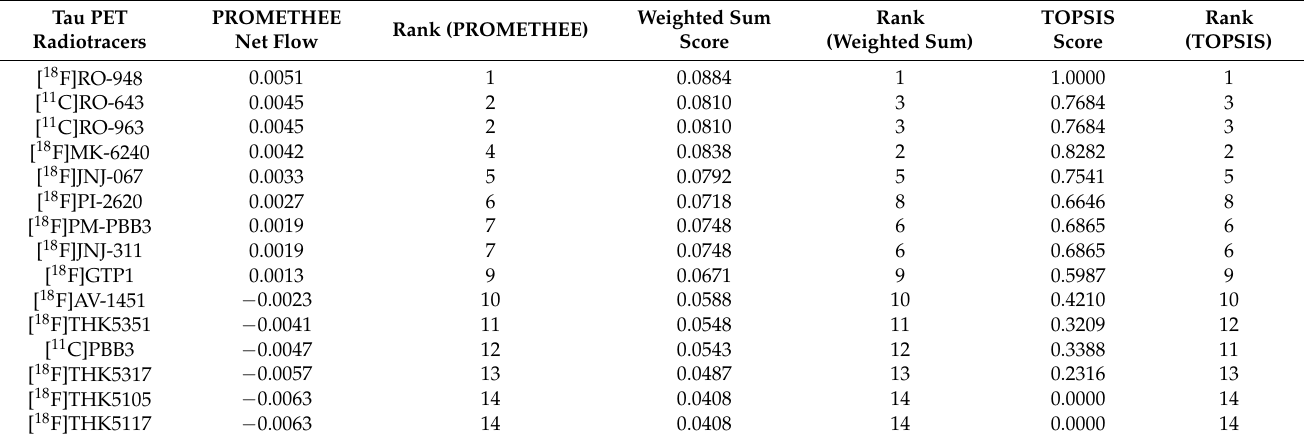
Table 6. Comparison of the ranking results obtained using different methods. The results obtained with PROMETHEE, TOPSIS, and weighted sum methods are in very good agreement and differ only